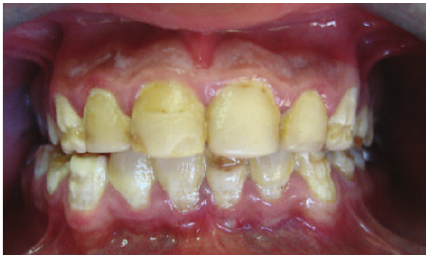
Figure 3: Anterior teeth had been restored with composite laminate veneers for esthetic